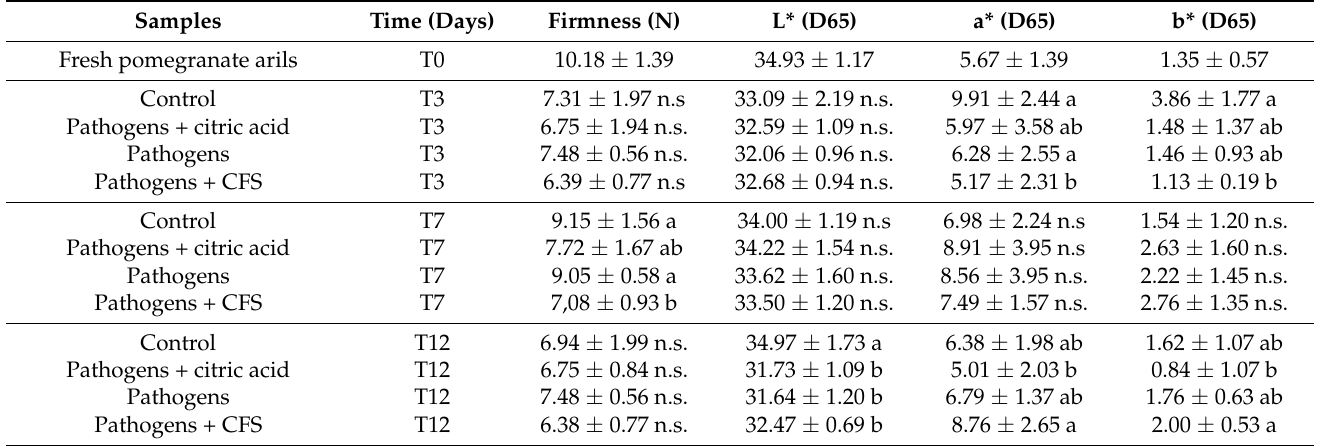
Table 5. Texture and color coordinates of pomegranate aril samples differently treated during